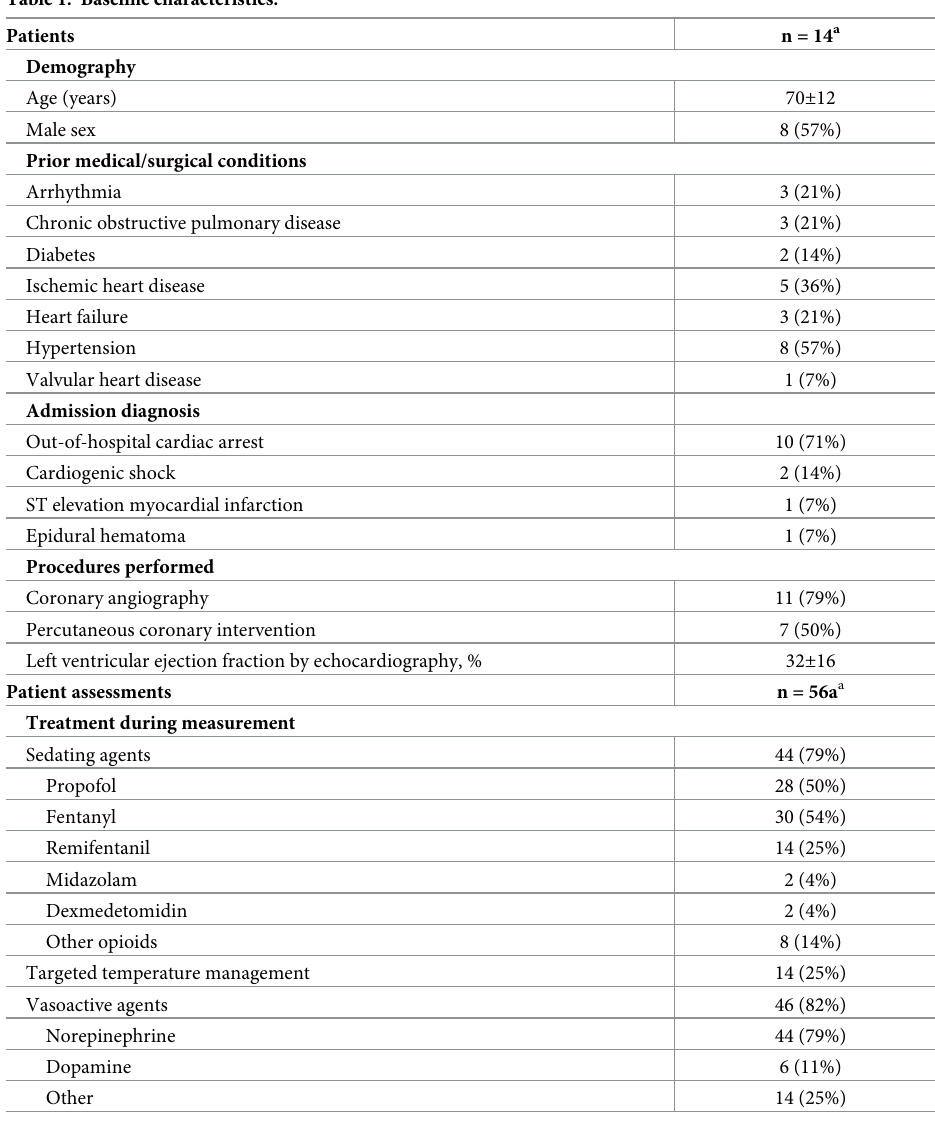
Table 1. Baseline